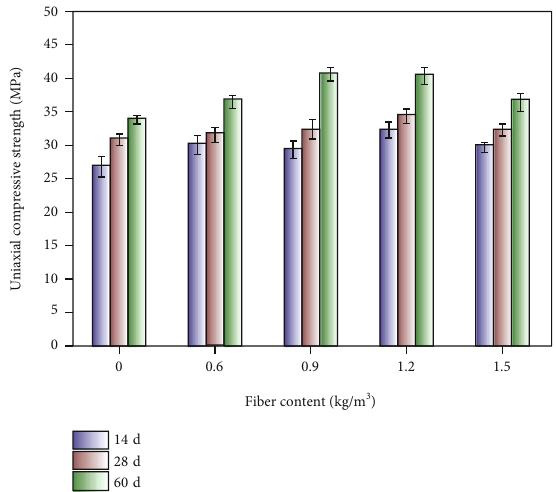
Figure 17: Uniaxial compression strength of PC and PPFRC at di ff erent curing ages. Table 7: Growth rate of uniaxial compression strength of PC and PPFRC at di ff erent curing ages.